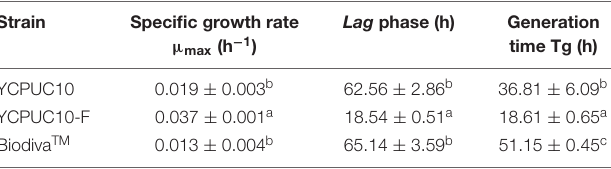
TABLE 3 | Growth kinetic parameters of the growth of T. delbrueckii strains in synthetic must with 50 mg/L of free SO 2 .